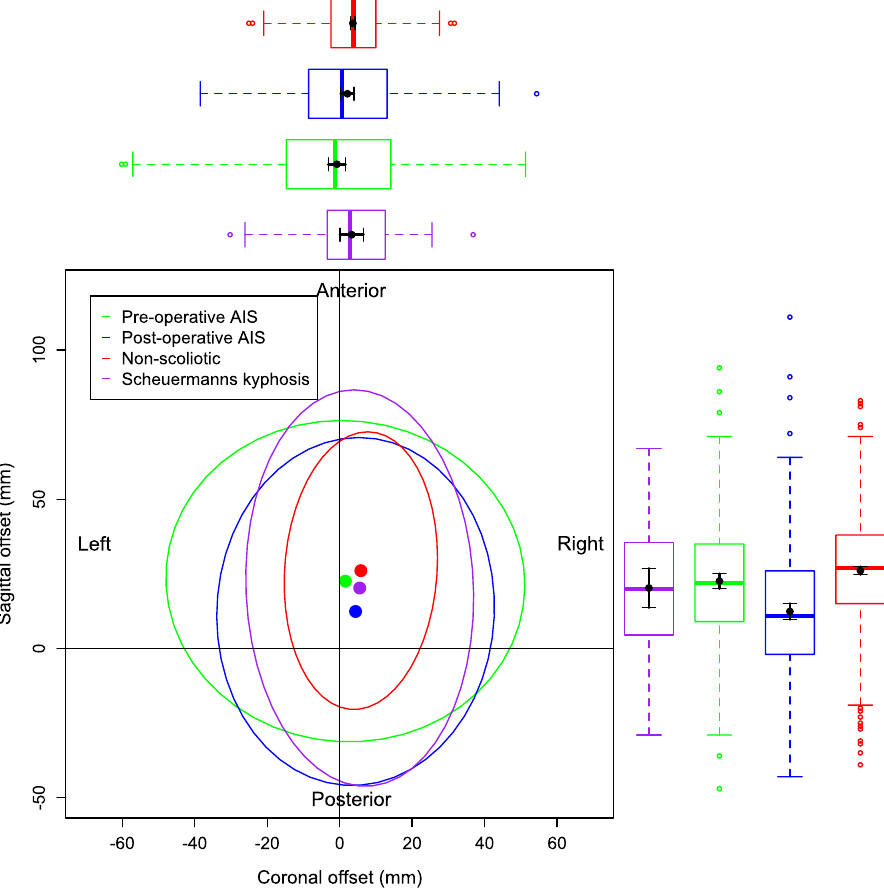
Figure 6. The mean values and 95% confidence ellipses for the non-scoliotic (red), pre-operative AIS (green), post-operative AIS (blue) and SK (purple) groups. This plot only shows the mean values and 95% confidence ellipses for